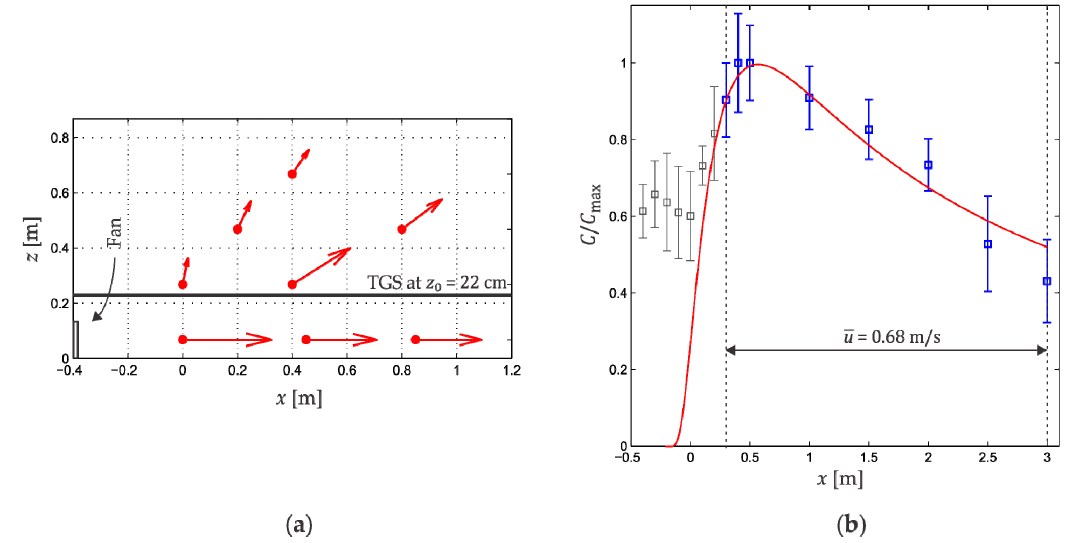
Figure 8. ( a ) Wind distribution in the xz plane; ( b ) Experimental concentration profile at a height z 0 = 22